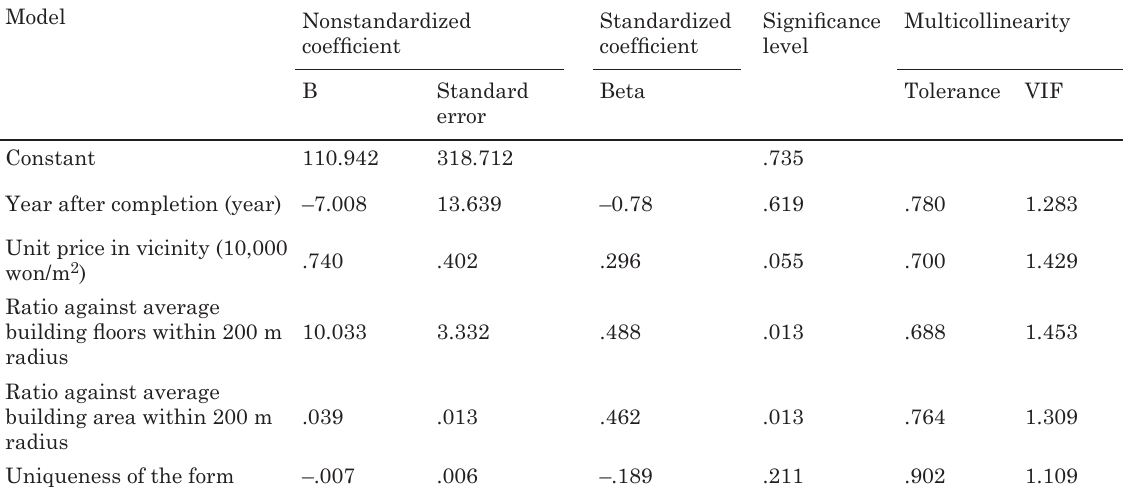
table 10. results of regression analysis of areas other than Gangnam-area and yeongdeungpo-gu model